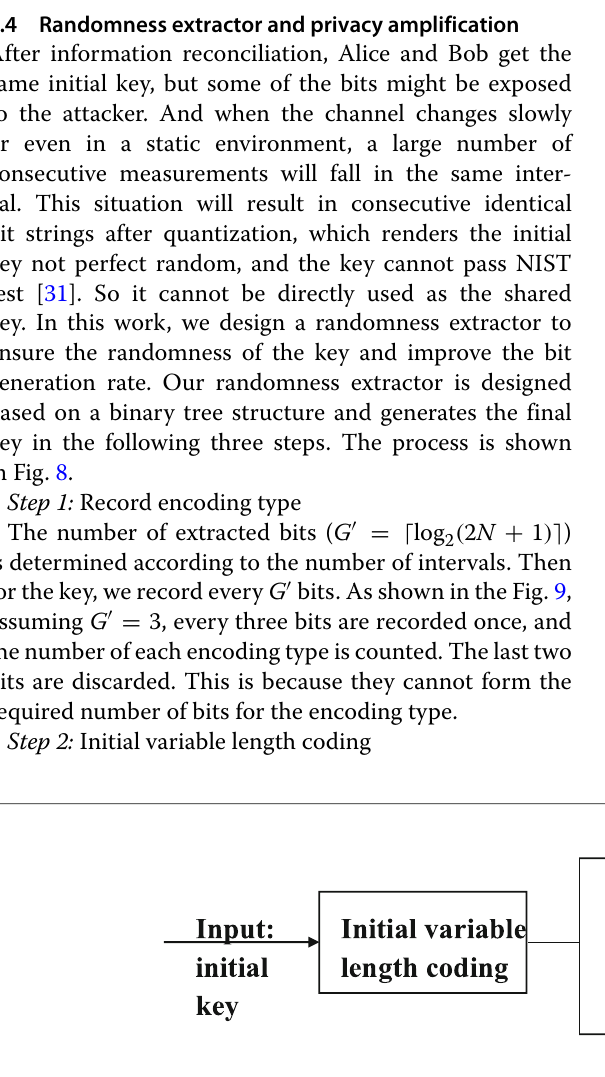
Fig. 7 Correct information